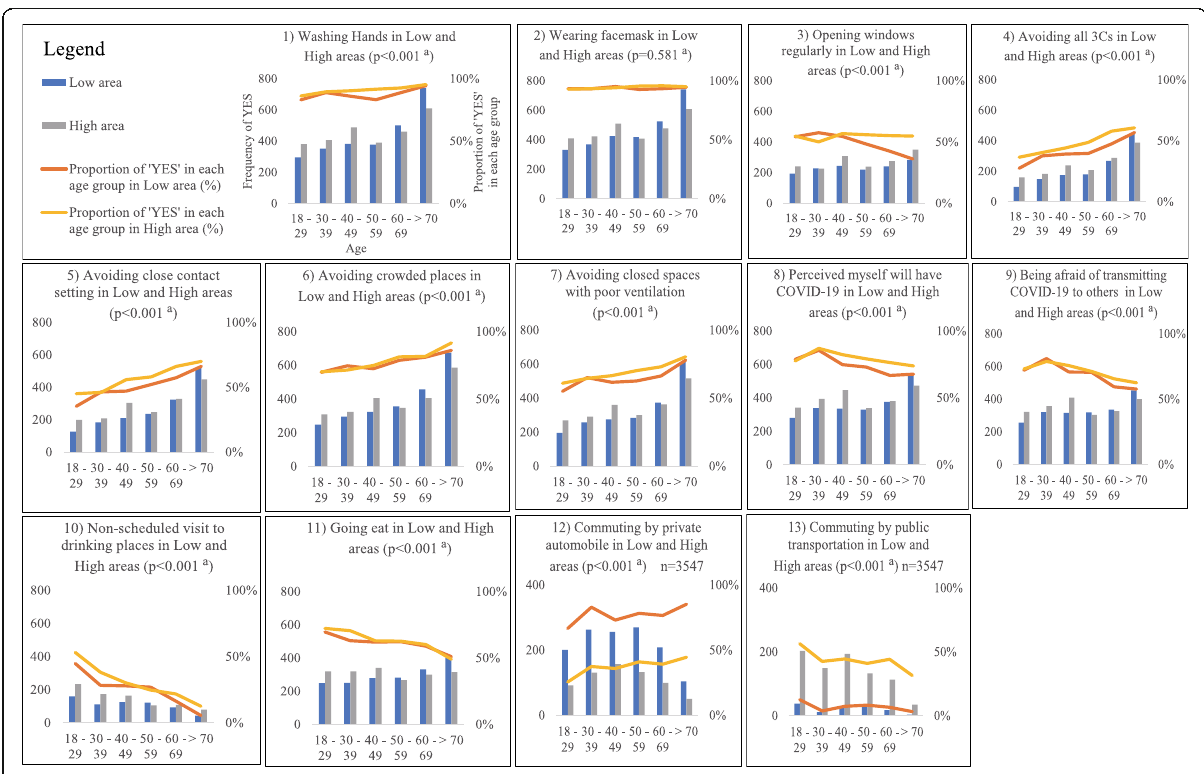
Fig. 3 (1 – 13) Behaviours and perceptions between low and high COVID-19 incidence areas by six age groups. Low: Low-COVID-19-incidence- area; High: High-COVID-19-incidence-area. All the graphs are based on weighted figures; from (1) to (11), the sample size: 6000 respondents; (12) and (13), the sample size is based on commuting respondents: 3547 respondents. a p value is based on the chi-squared